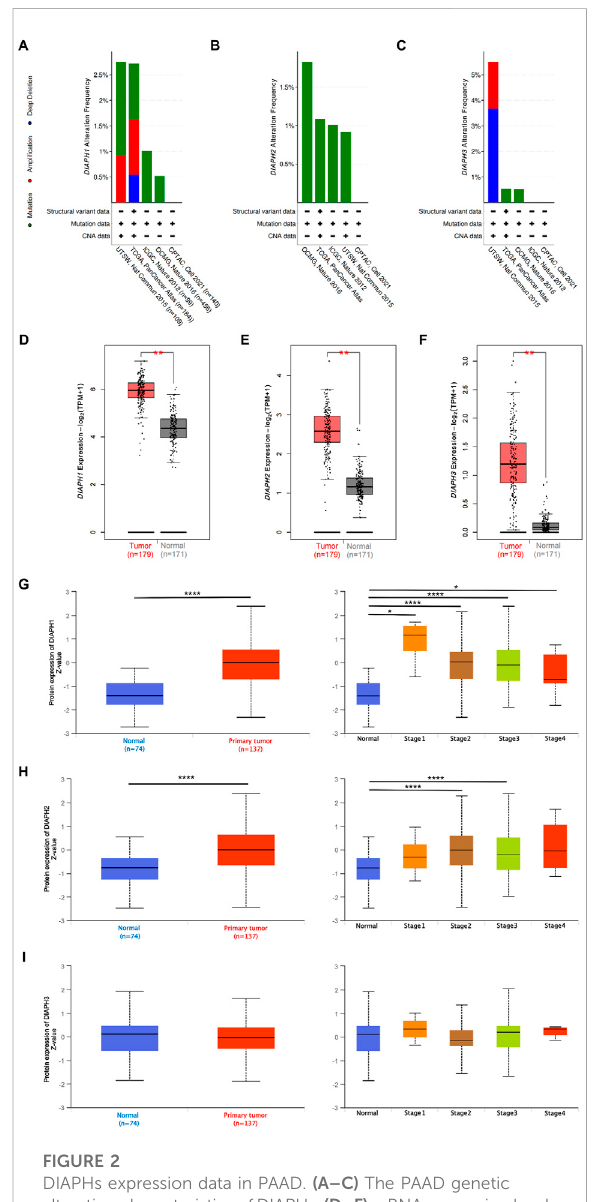
FIGURE 2 DIAPHs expression data in PAAD. (A – C) The PAAD genetic alterationcharacteristicsofDIAPHs. (D – F) mRNAexpressionlevels ofDIAPHsinPAAD. Log 2 (TPM+1) transformedtheexpressiondata for plotting. ** p < 0.01, in Wilcoxon test. (G – I) Total protein expression levels of DIAPHs in PAAD. Z values represent standard deviations from the median across samples. * p < 0.05, **** p < 0.0001, in Student ’ s t test. TPM, transcripts per